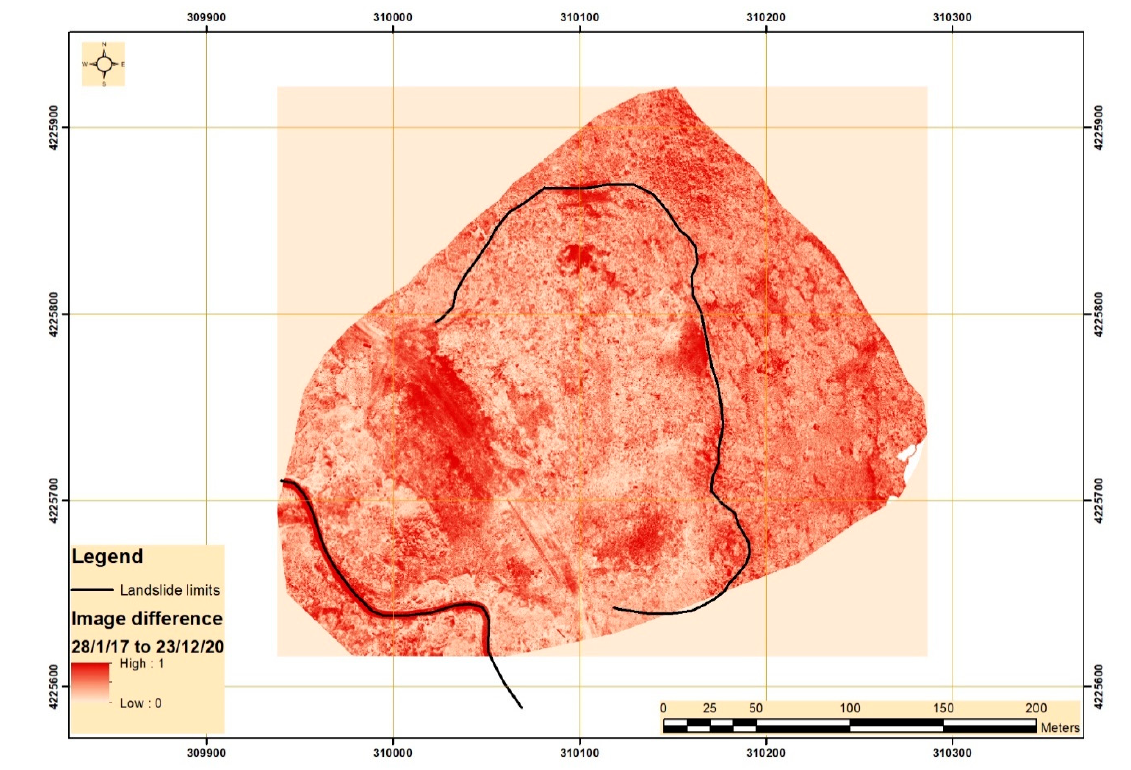
Figure 15. Difference between the orthophotos of 28 January 2017 and 23 December 2020.